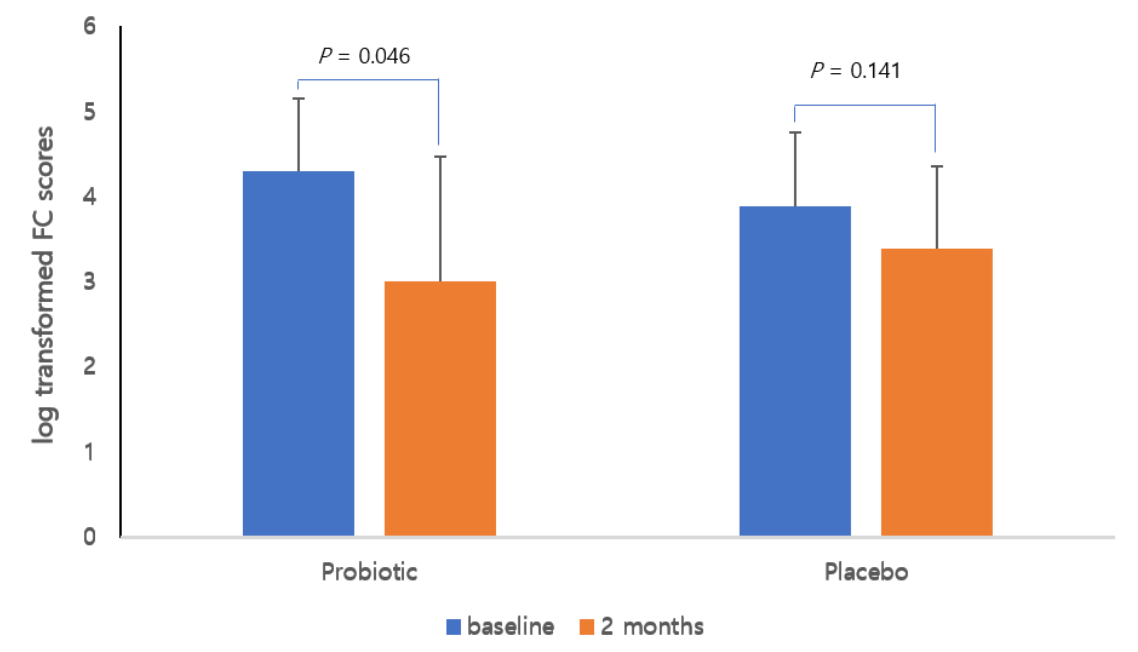
Figure 3. Changes in log-transformed fecal calprotectin levels in each group. Line graphs show the mean and standard deviation.